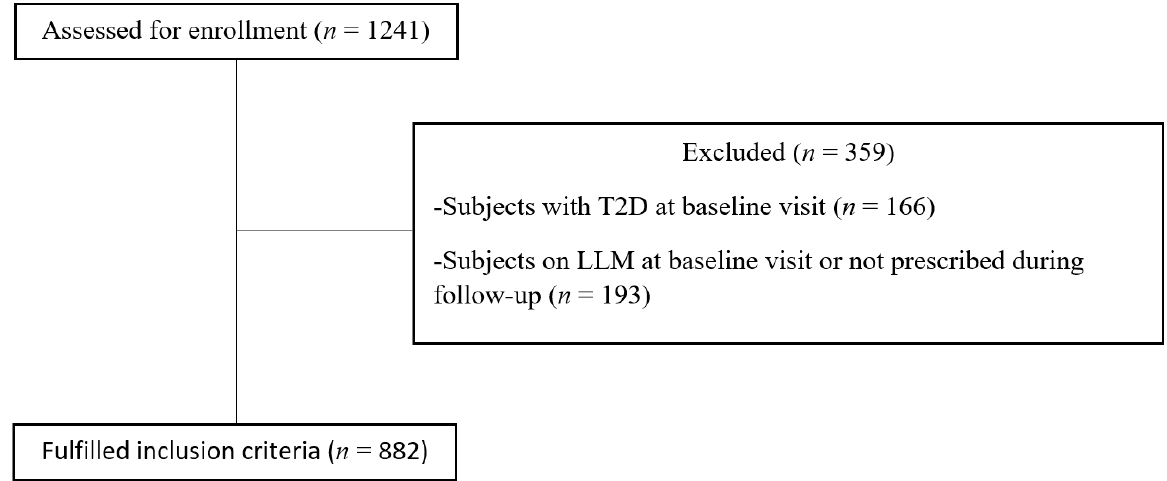
Figure 1. Study flowchart. T2D, type 2 diabetes; LLM, lipid-lowering medication.